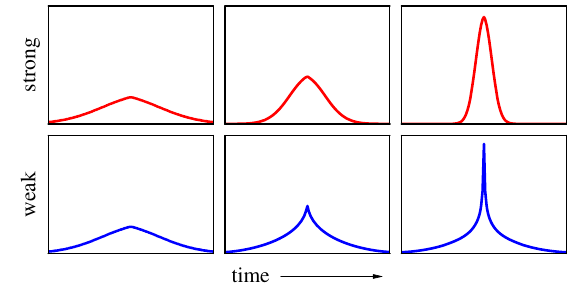
FIG. 1. Strong versus weak collapse (cartoon). In strong collapse, a finite portion of the wave (here 100%, for simplicity) collapses towards the singularity. In weak collapse, as time progresses, a diminishing fraction of the wave approaches the singularity, with long tails left